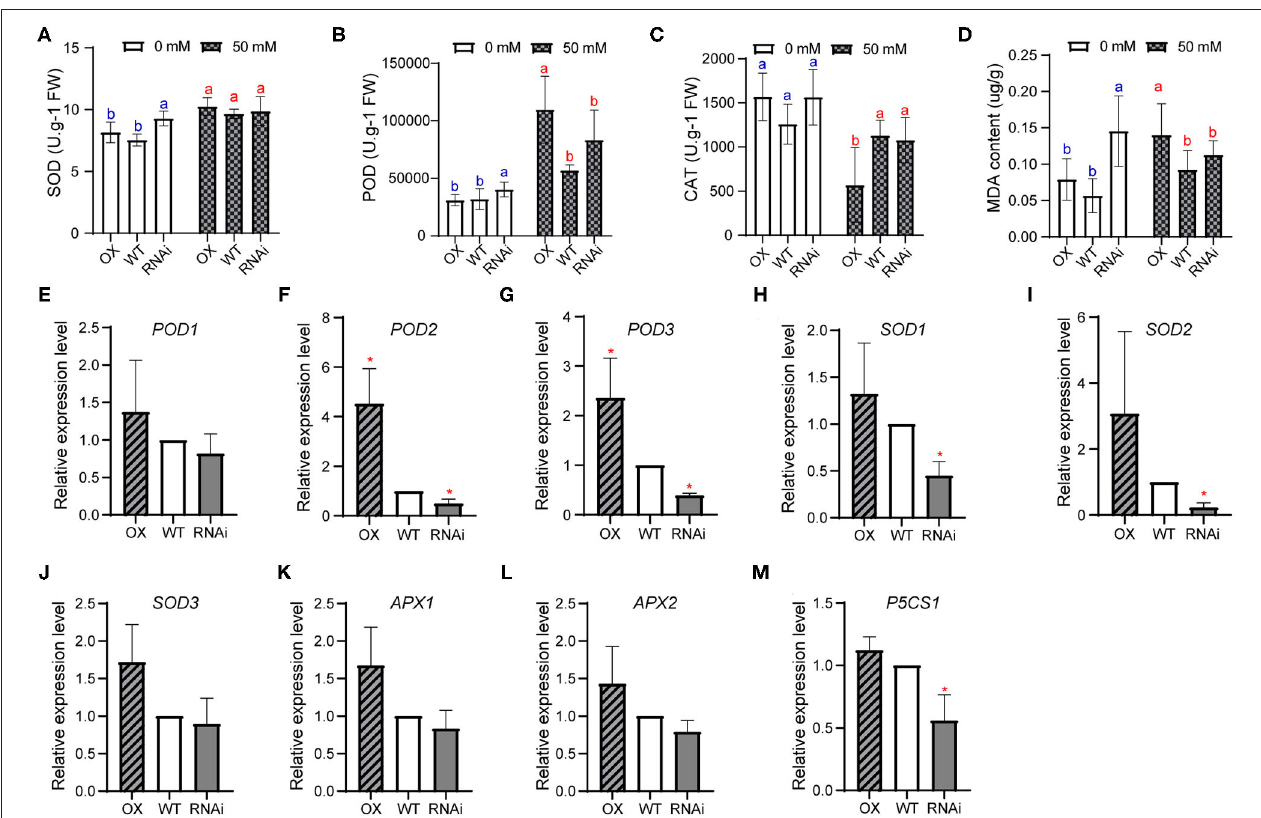
FIGURE 5 | PagERF16 modulated the physiology and gene expression relevant to antioxidant enzymes. (A–D) Superoxide dismutase (SOD), peroxidase (POD), catalase (CAT), and MDA contents. The plot represents the mean ± SD of six plants per line. Three OX or RNAi lines serve as three biological repeats. Different lowercases indicate significant differences among samples ( p ≤ 0.05). (E–M) Expression of POD1 , POD2 , POD3 , SOD1 , SOD2 , SOD3 , APX1 , APX2 , and P5CS1 in transgenic and WT plants. The plot represents the mean ± SD of three repeats. Asterisks denote significant differences between transgenic and WT: * p ≤